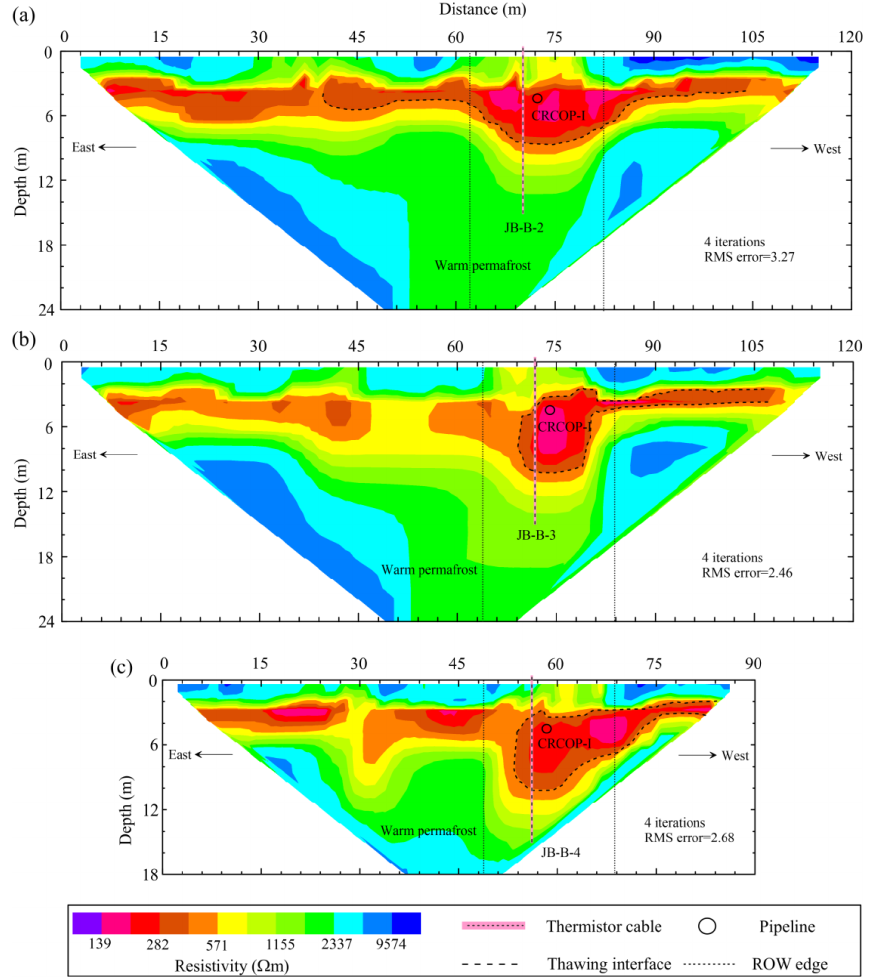
Figure D3. Inversion results of electrical imaging along monitored cross sections with thermosyphons at the JB site, carried out in April 2018. Notes: (a) P-JB-2 profile – one pair of thermosyphons, (b) P-JB-3 profile – two pairs of thermosyphons at a longitudinal spacing of 1.3m, and (c) P-JB-4 profile – two pairs of thermosyphons at a longitudinal spacing of